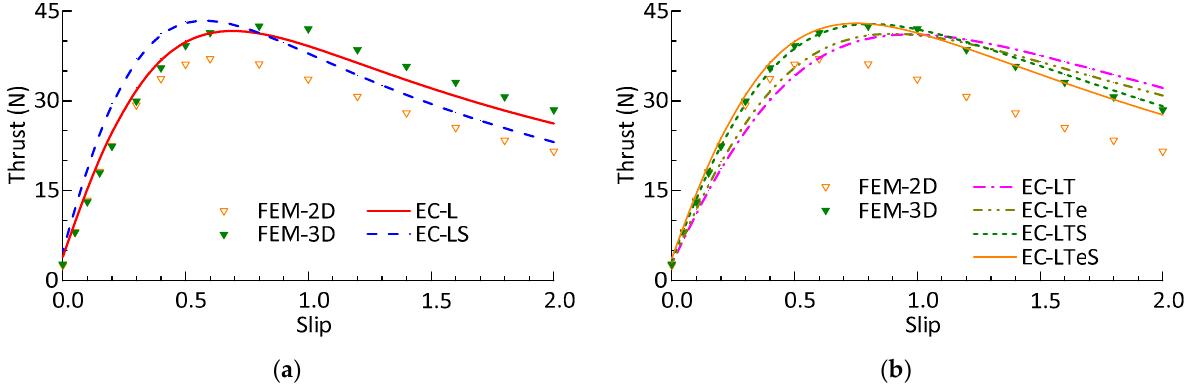
Figure 7. Thrust versus slip characteristics with a mechanical gap of 0.0075 m: ( a ) is calculated by equivalent circuit with longitudinal end effect (EC-L), skin effect, the air gap leakage, and longitudinal end effect considered (EC-LS), FEM 2D, and FEM 3D model; ( b ) is calculated by longitudinal end effect, transverse end effect (EC-LT, EC-LTe), in addition to skin effect and secondary leakage reactance considered (EC-LTS, EC-LTeS), FEM 2D and 3D model.